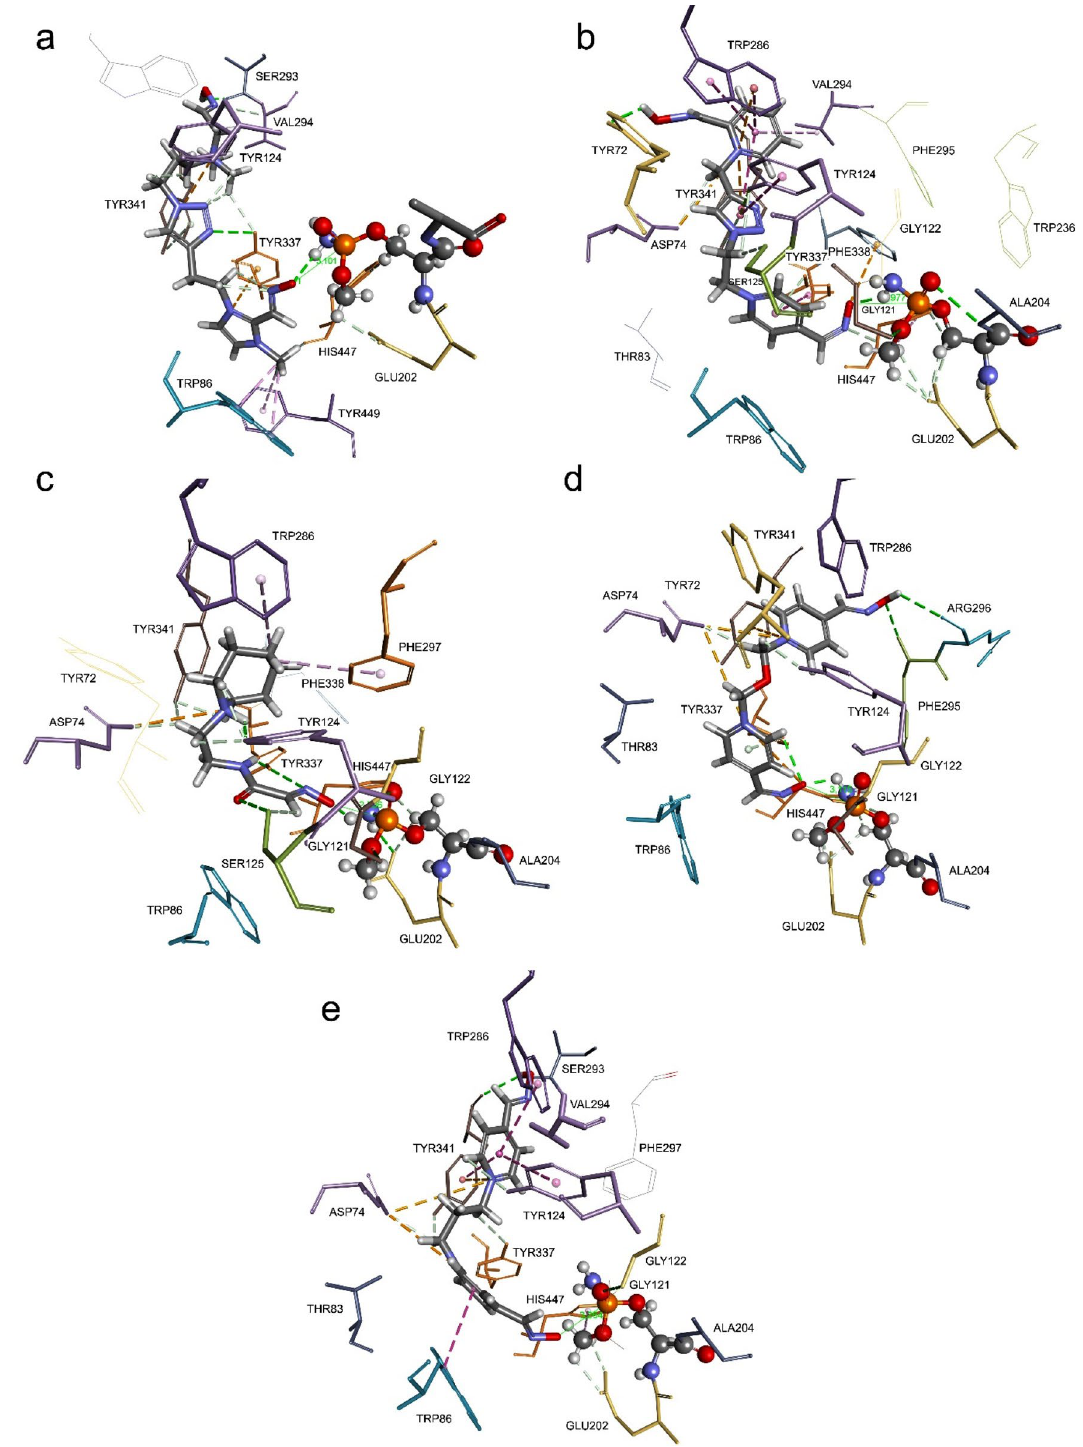
Figure 7. Model of reversible complex between oxime reactivator and methamidophos hAChE conjugate. Docked compounds are: 1A ( a ), 14A ( b ), RS194B ( c ), obidoxime ( d ), and TMB-4 ( e ). The catalytic Ser203- methamidophos conjugate is presented as a stick and ball. Interactions with amino acid residues are represented as dashed lines: hydrophobic (purple), hydrogen bonds (green) and electrostatic